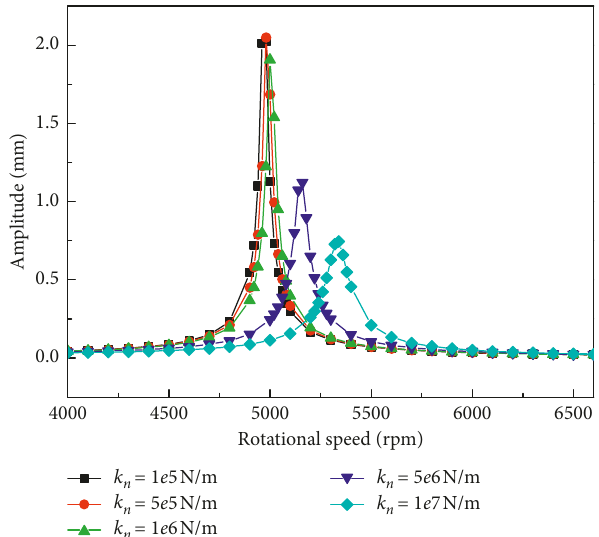
Figure 9: The influence of normal contact stiffness between shrouds on the vibration